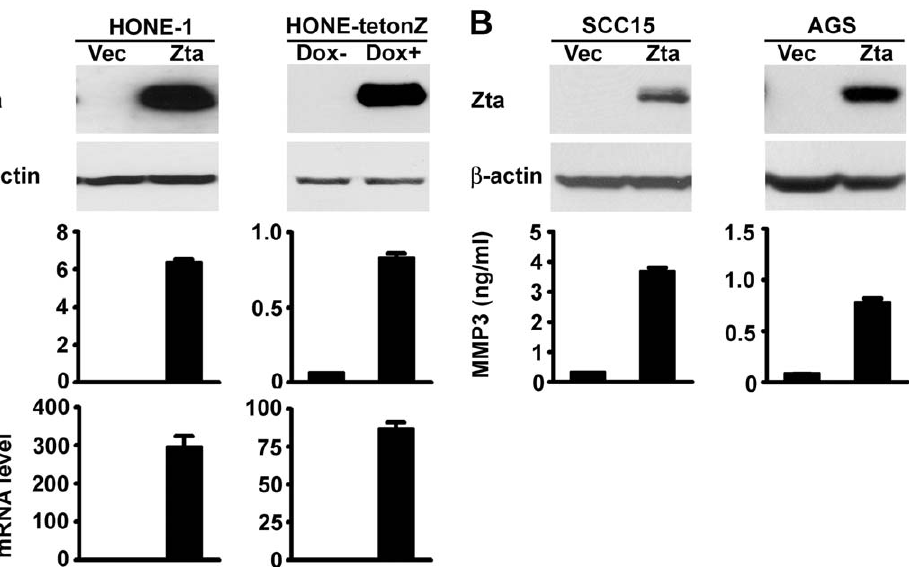
Figure 2. Zta induces MMP3 expression. ( A ) HONE-1 cells were transfected with a vector plasmid (Vec) or a Zta-expressing plasmid, and HONE- tetonZ cells were treated with ( + ) or without (-) doxycycline (Dox). In the upper panel, protein expression of Zta and b -actin was examined by an immunoblotting assay. In the middle panel, concentrations of MMP3 protein in the cell culture supernatants were quantified by using ELISA. In the lower panel, the expression levels of MMP3 mRNA were measured by quantitative RT-PCR. ( B ) SCC15 and AGS cells were transfected with a vector plasmid (Vec) or a Zta-expressing plasmid. Expression of Zta and b -actin was examined by an immunoblotting assay, and concentrations of MMP3 protein in the cell culture supernatants were quantified by using ELISA.